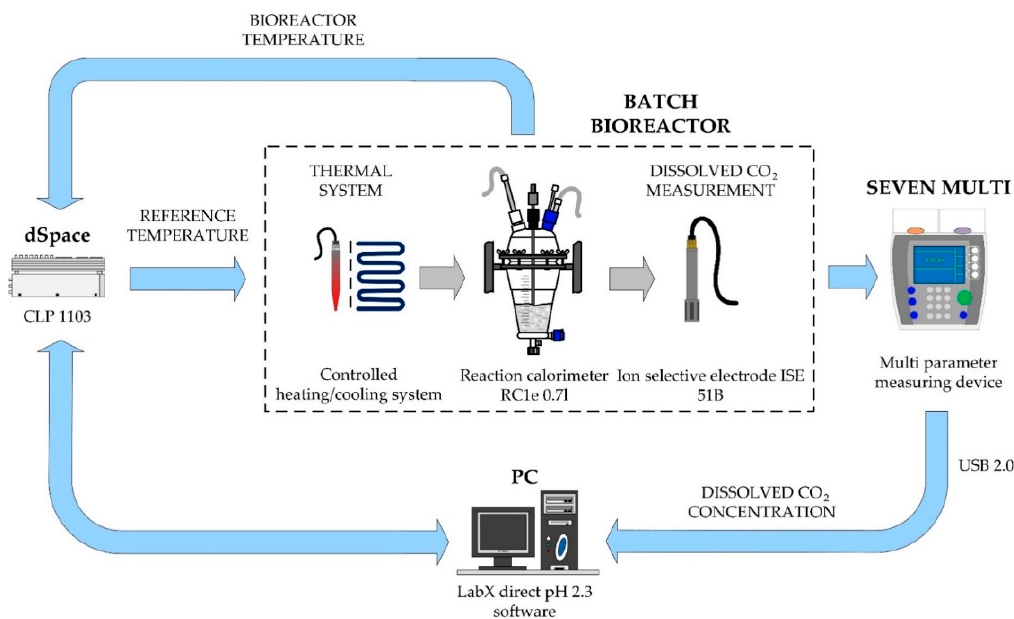
Figure 1. Laboratory system for experiments and identification of the mathematical model.